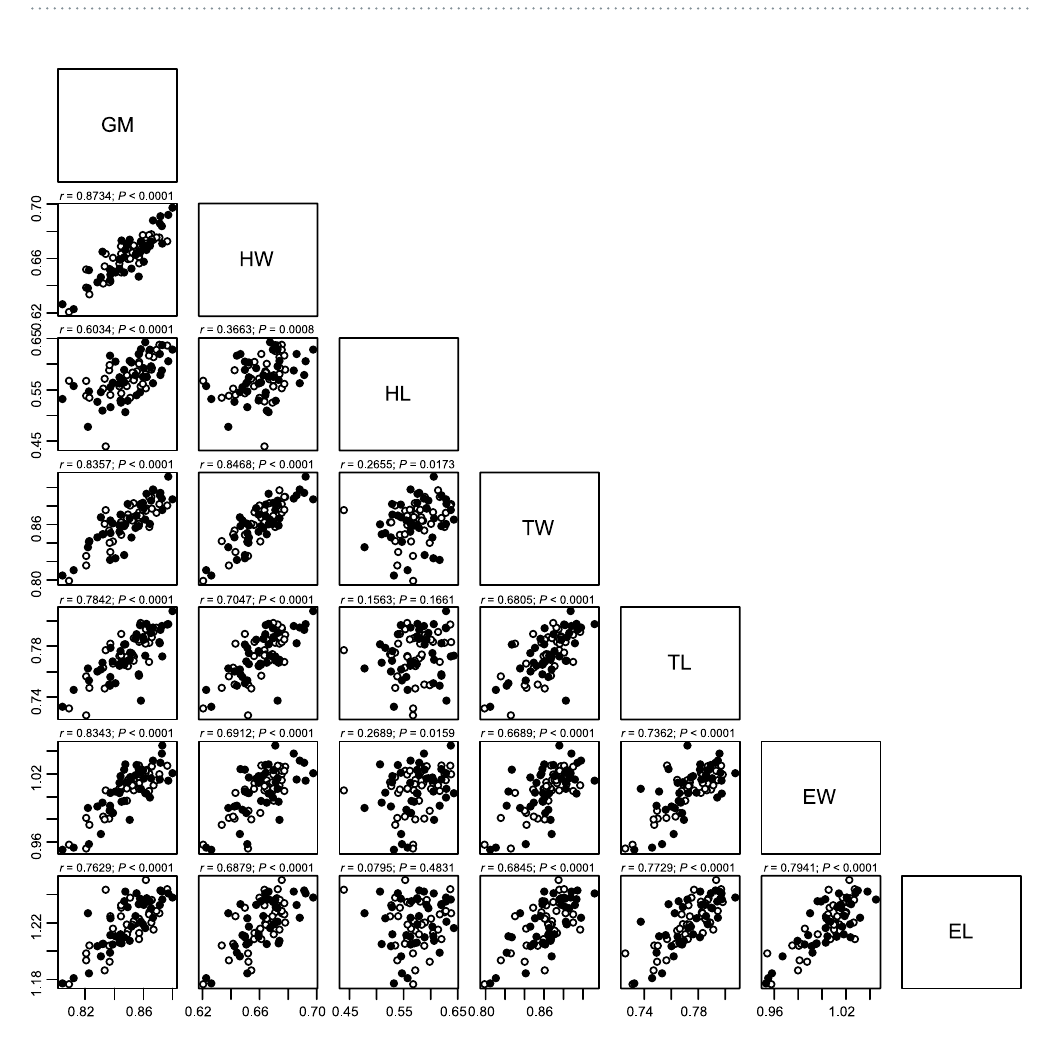
Figure 3. Correlations between body size dimensions. The values in millimetres were log 10 transformed and adjusted for sex differences. Open and closed circles indicate male and female individuals, respectively. Pearson correlation coefficients ( r ) and P values are given in the panels. The body dimensions are described in the legend of Fig.